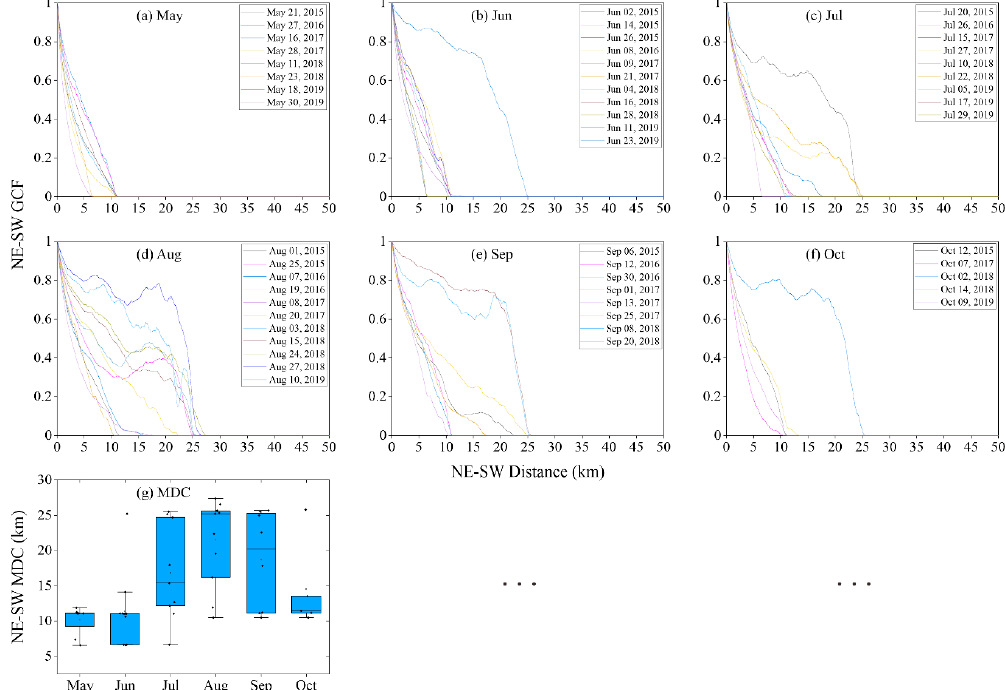
Figure 8. Changes in the geospatial connectivity function (GCF) and maximum distance of connection (MDC) in the NE–SW direction of the Momoge National Nature Reserve, China from 2015 to 2019. ( a – f ) indicate May to October and ( g ) indicates MDC.